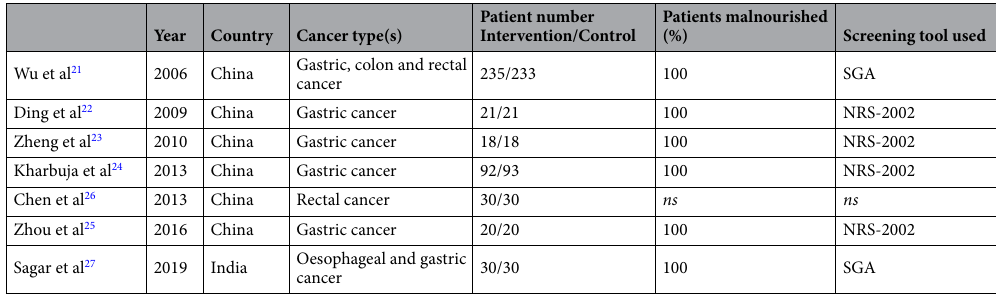
Table 1. Summary of included randomised control trials. SGA Subjective Global Assessment, NRS Nutritional Risk Screening, ns not